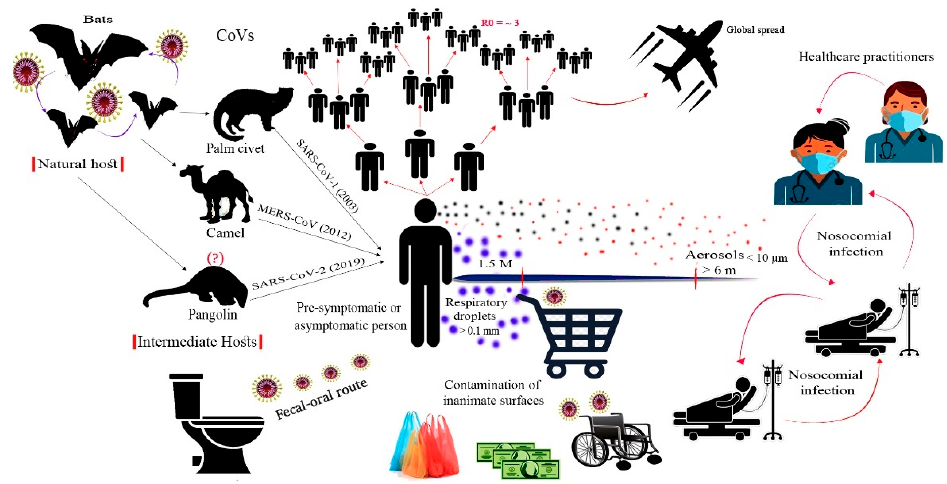
Figure 2. Origin and transmission of SARS-CoV-2. The virus is believed to be originated from bats and spread to humans through an intermediate host. Human-to-human transmission mainly occurred by respiratory aerosols generated when an infected person sneezes or speeches. Respiratory aerosols can travel to long distances, whereas respiratory droplets settle down on nearby surfaces and represent a possible risk of infection. Basic reproduction number (R0) of the virus is estimated as 3.6. The faecal-oral route of transmission was reported due to the ability of the virus to replicate in the gastrointestinal tract. Within hospital settings, nosocomial infection is also known to occur among healthcare practitioners and hospitalized